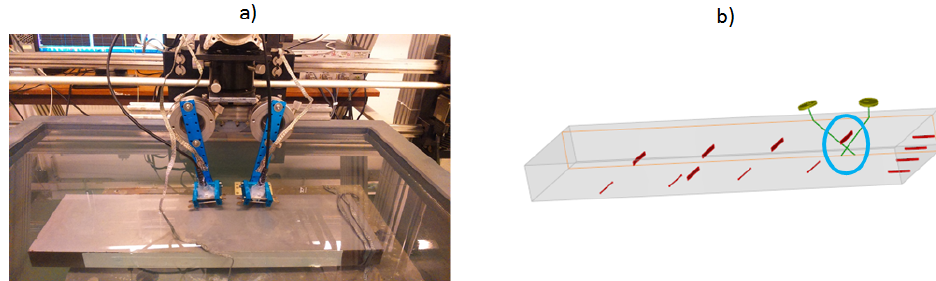
Figure 14. ( a ) Photograph of the setup; ( b ) TOFD inspection configuration using immersion probes: study of P45 echoes scattered by the flaw surrounded in blue.